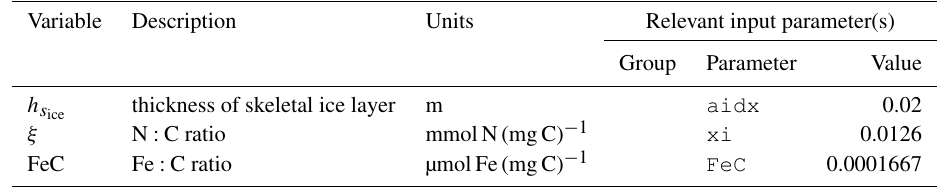
Table A3. Notation and description for input parameters applicable to all biomass rate-of-change